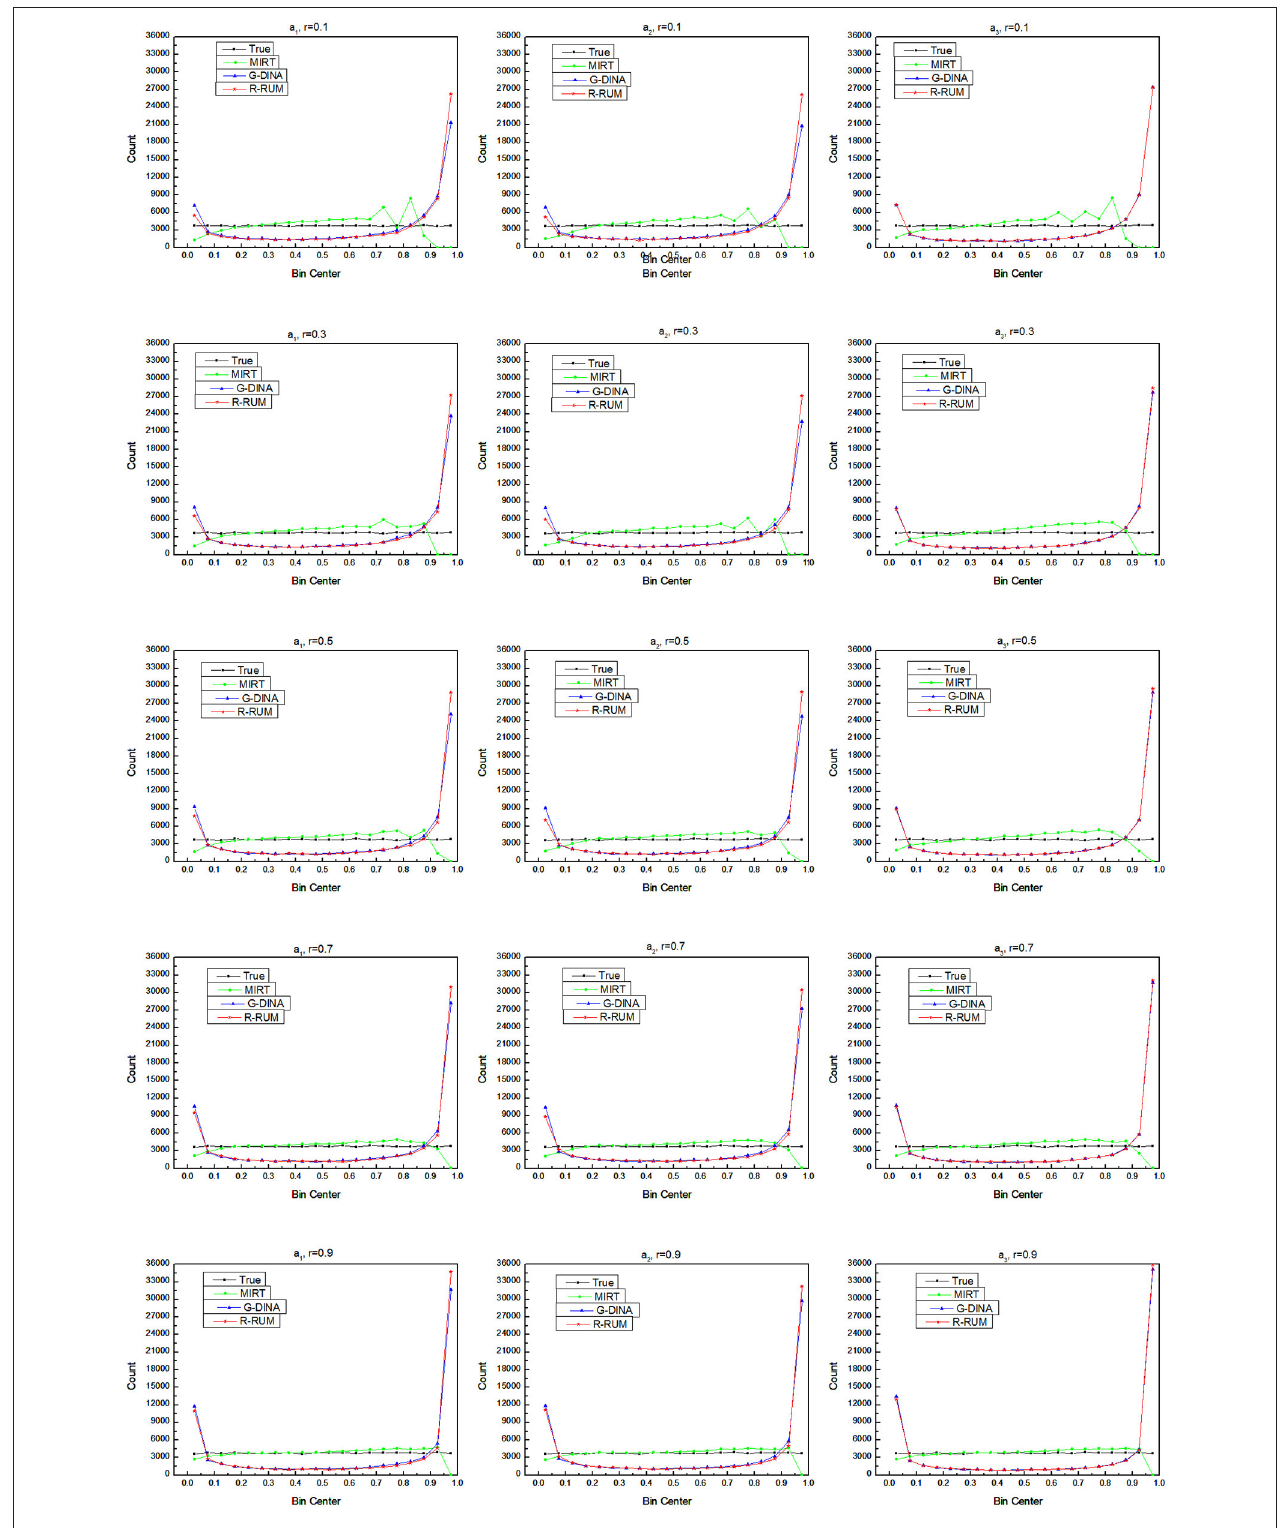
FIGURE 3 | Comparison of frequency distributions of subskill mastery